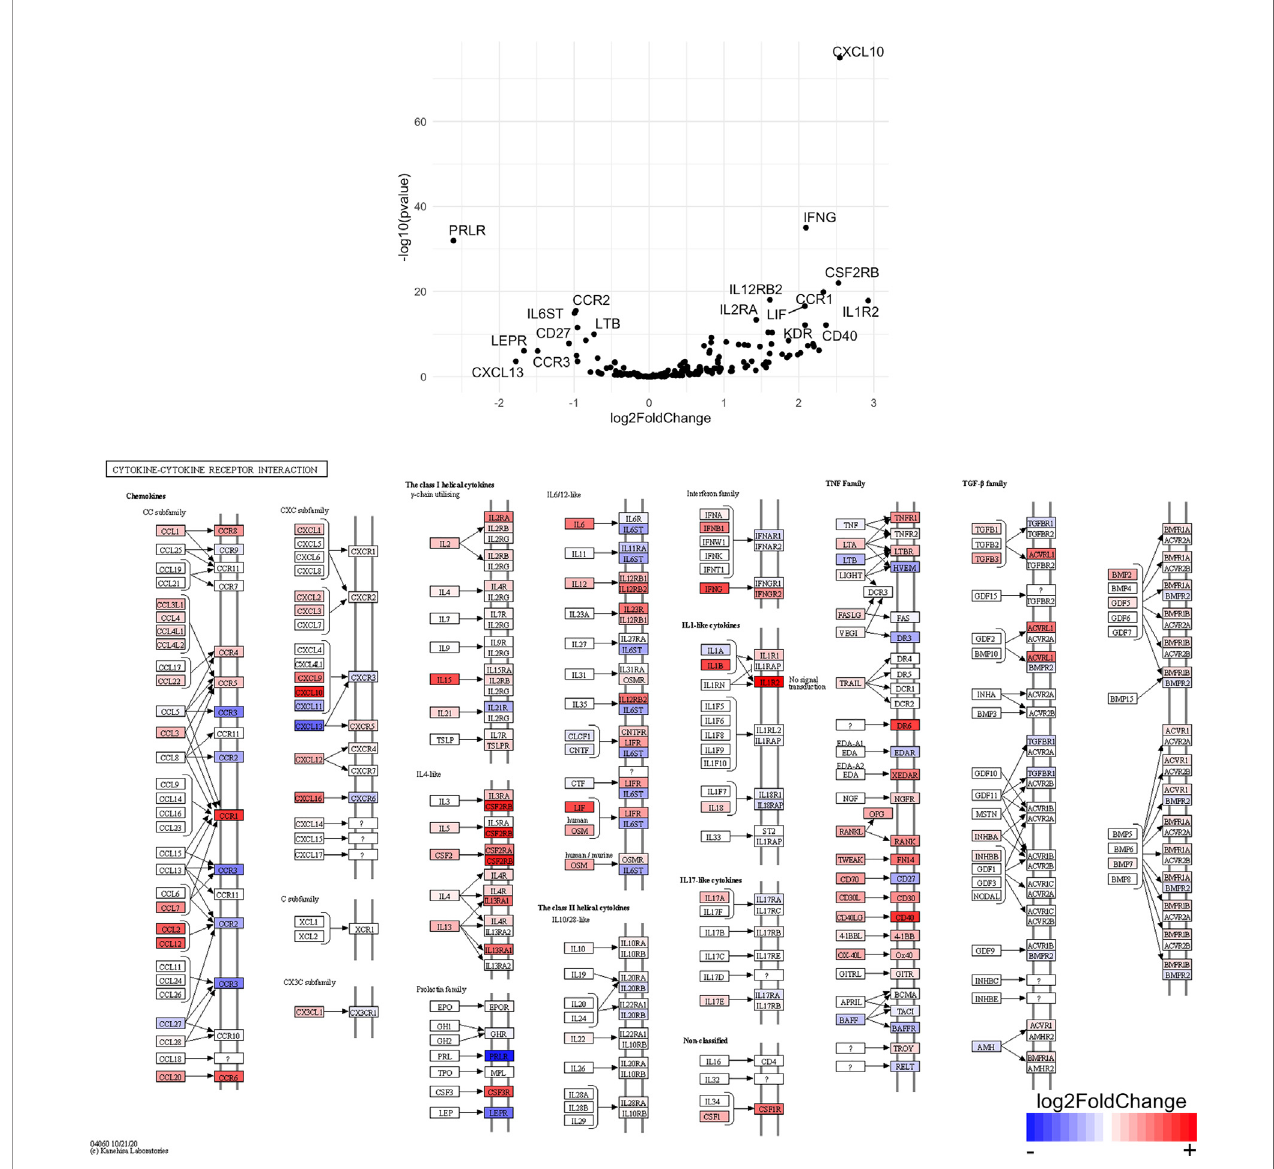
FIGURE 10 | Genes related to cytokine-cytokine receptor interaction are enriched in CD4 + T cells from the CNS of microglia-de fi cient B6J mice compared to microglia-de fi cient SJL mice. C57BL/6J and SJL/J mice were treated with a PLX5622-supplemented diet seven days prior to i.c. TMEV infection and sacri fi ced at 6 DPI for analysis (n = 10 mice per group). Volcano plot of RNA-seq transcriptome data and KEGG map display cytokine-cytokine receptor interaction-related gene expression in enriched CD4 + T cells from the CNS of microglia-de fi cient C57BL/6J mice relative to microglia-de fi cient SJL/J